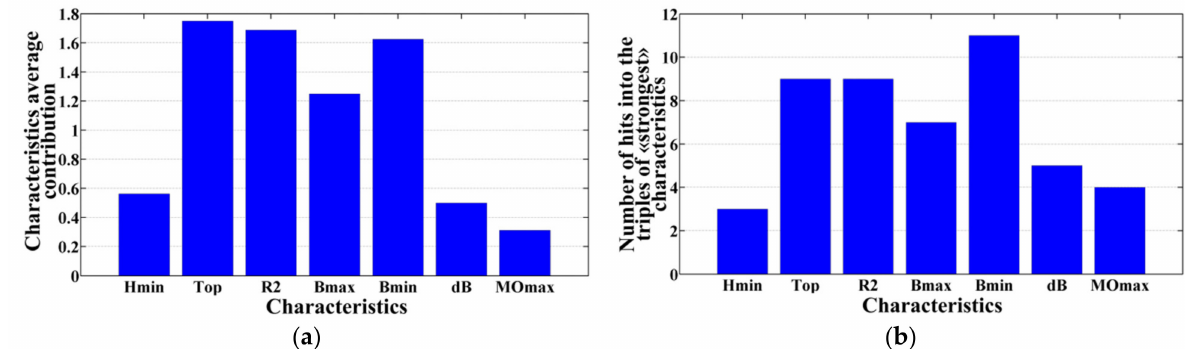
Figure 3. The contribution of characteristics to recognition using the Barrier-3 algorithm of a high seismicity set of objects in the Altai–Sayan–Baikal region: ( a ) average contribution of characteristics; ( b ) the contribution of characteristics expressed through their attribution to the “strongest”